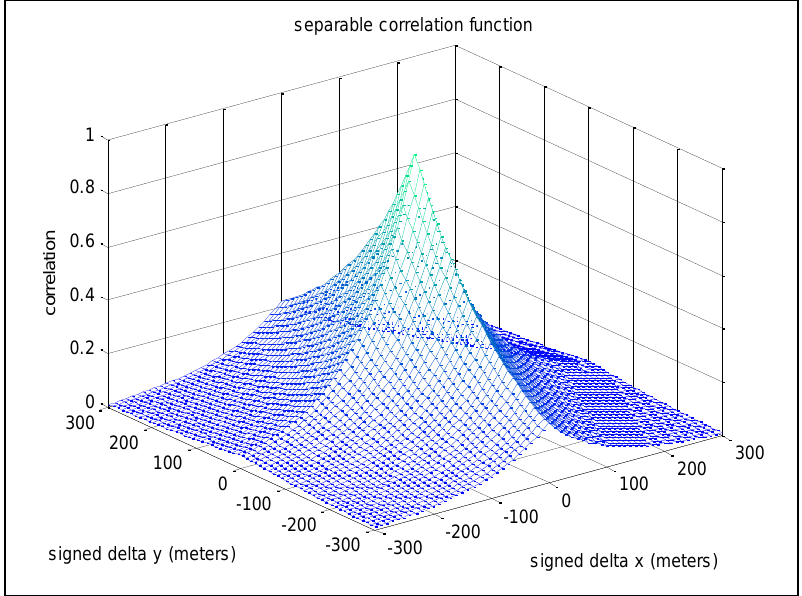
Figure 1. An example of the separable spatial correlation function; in the plot of , and have signed